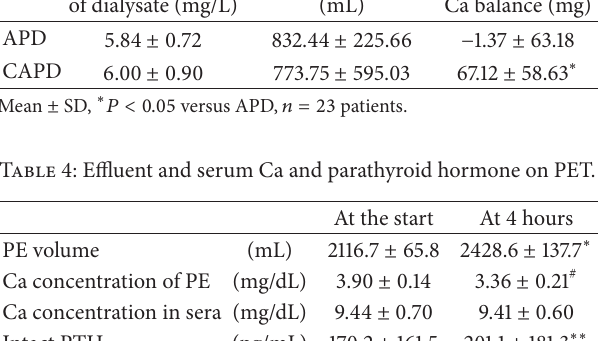
Table 2: Twenty-four-hour collected peritoneal effluent on APD and CAPD in same PD patients. Dwell volume Drain volume Ca of PDS (mL) (mL) (mg/dL)